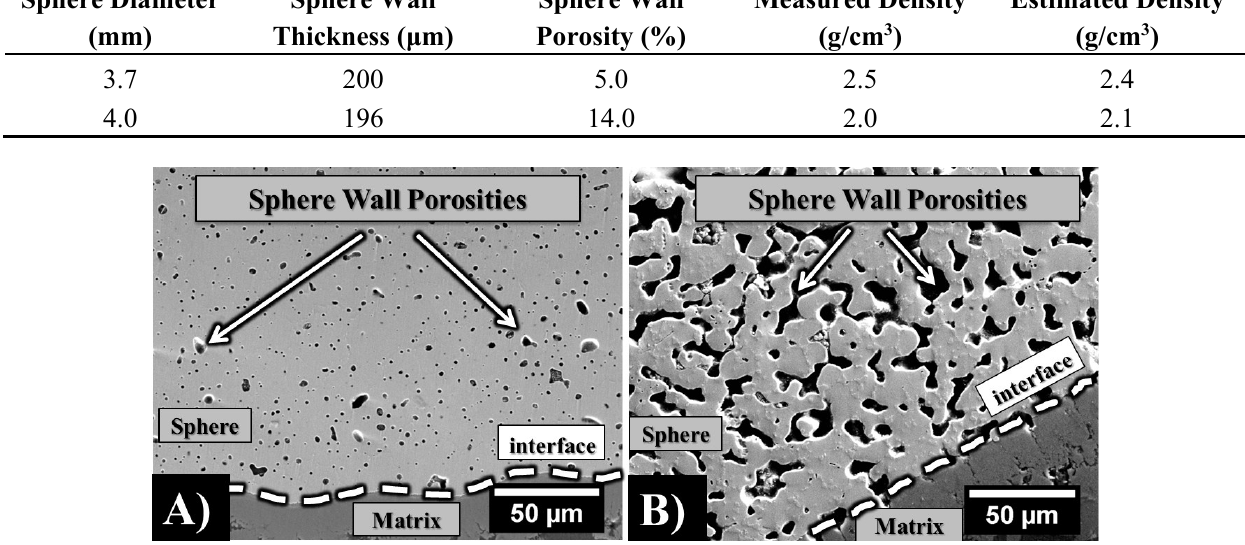
Figure 5. Secondary electron SEM images of the sphere wall microstructure for Al-S CMF made with ( A ) 3.7 mm and ( B ) 4.0 mm sphere.